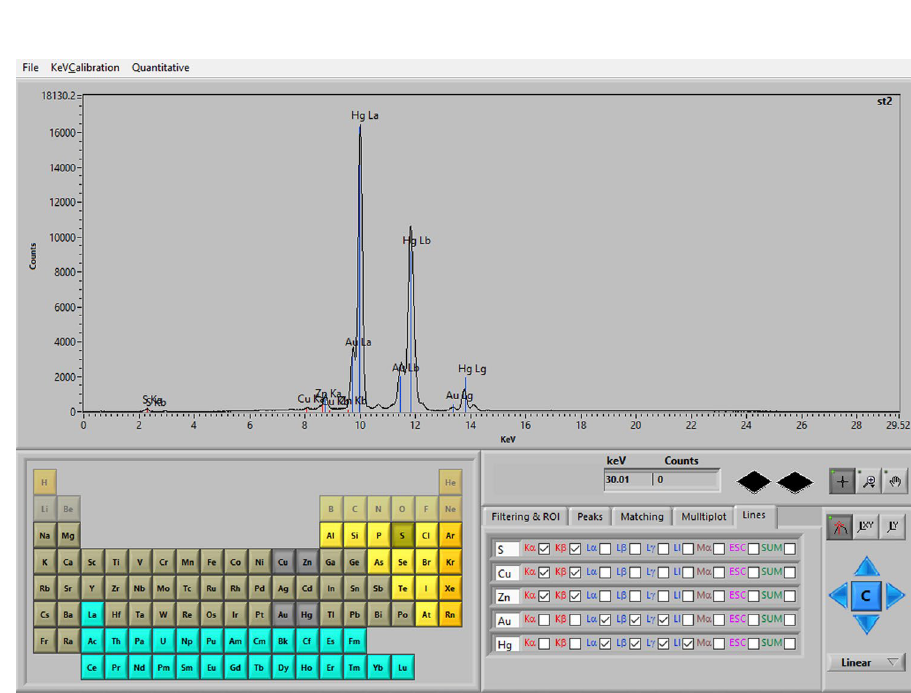
Fig. 4 The XRF match